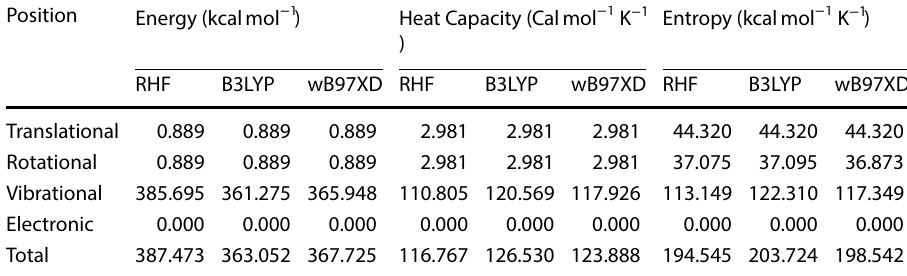
Table 6 Thermodynamic properties of andirobin at T = 298.15 K and P = 1 atm